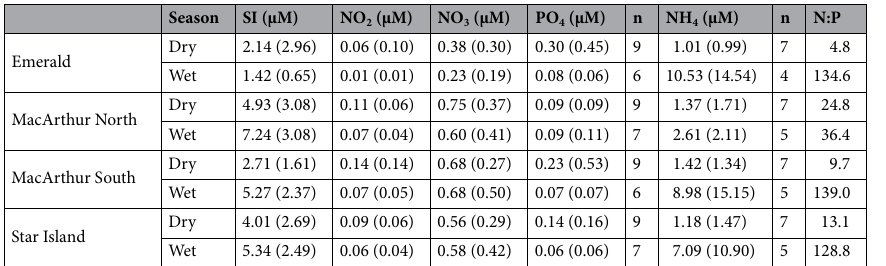
Table 2. Nutrient concentration at a natural coral reef (Emerald) and three inshore urban sites (MacArthur North, MacArthur South, and Star Island), separated by season (Wet and Dry). Values are means and standard deviations are in parentheses. Sample sizes denoted as n following the respective